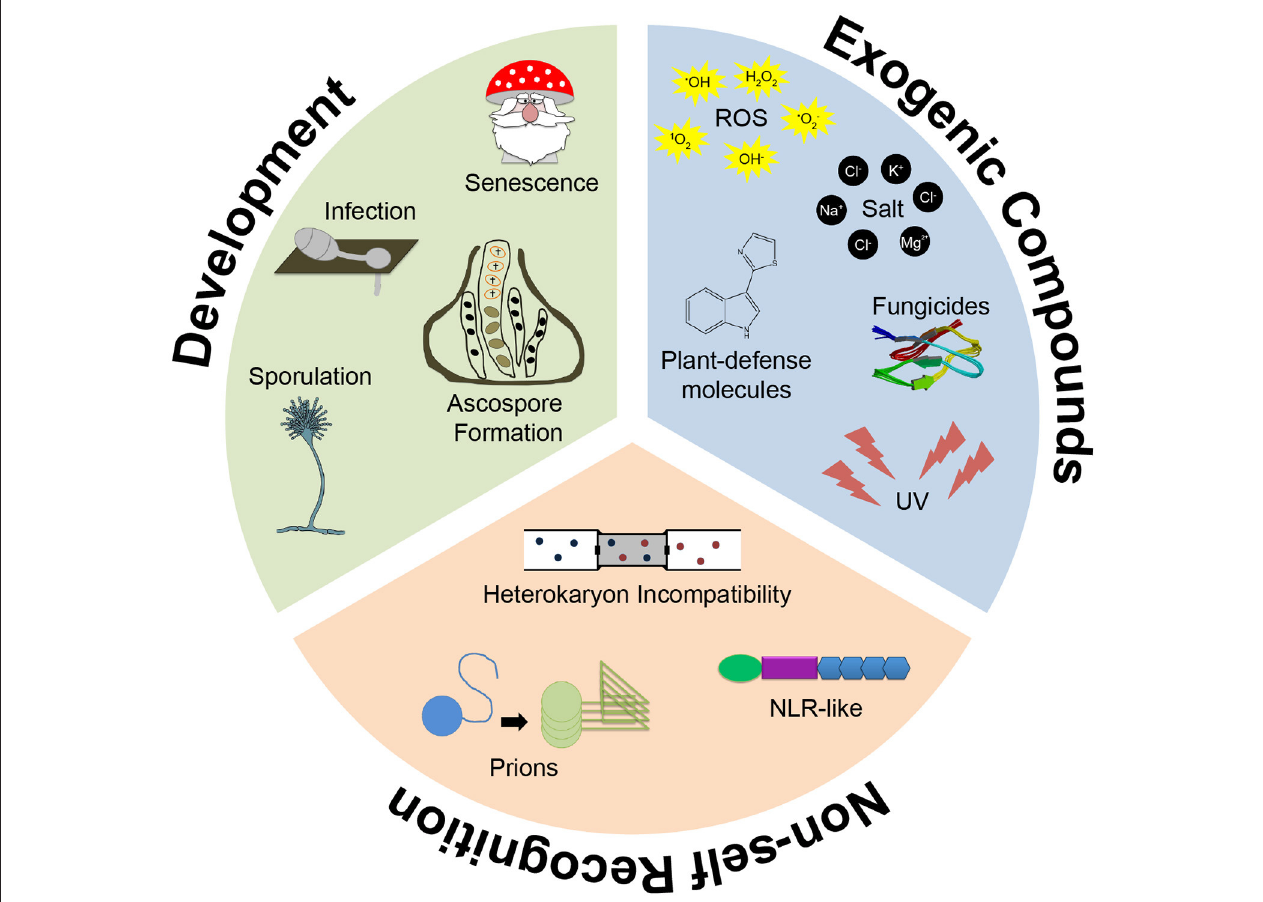
FIGURE 1 | Programmed Cell Death (PCD) in filamentous fungi. PCD has been reported to occur in filamentous fungi in response to various exogenic compounds, such as plant defense molecules (e.g., camalexin), toxins and fungicides (e.g., Penicillium AntiFungal protein), during non-self-recognition and heterokaryon incompatibility and during developmental programs throughout the fungal life cycle, including morphogenesis associated plant